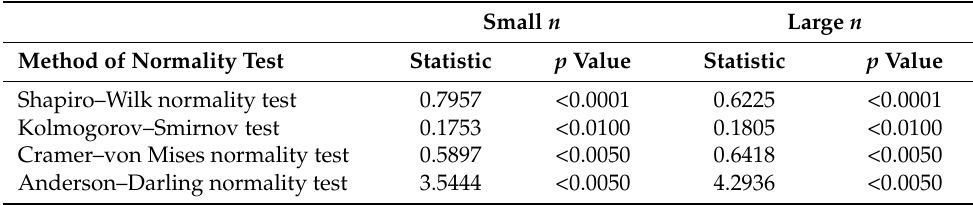
Table 4. Normality Tests for small n and large n .